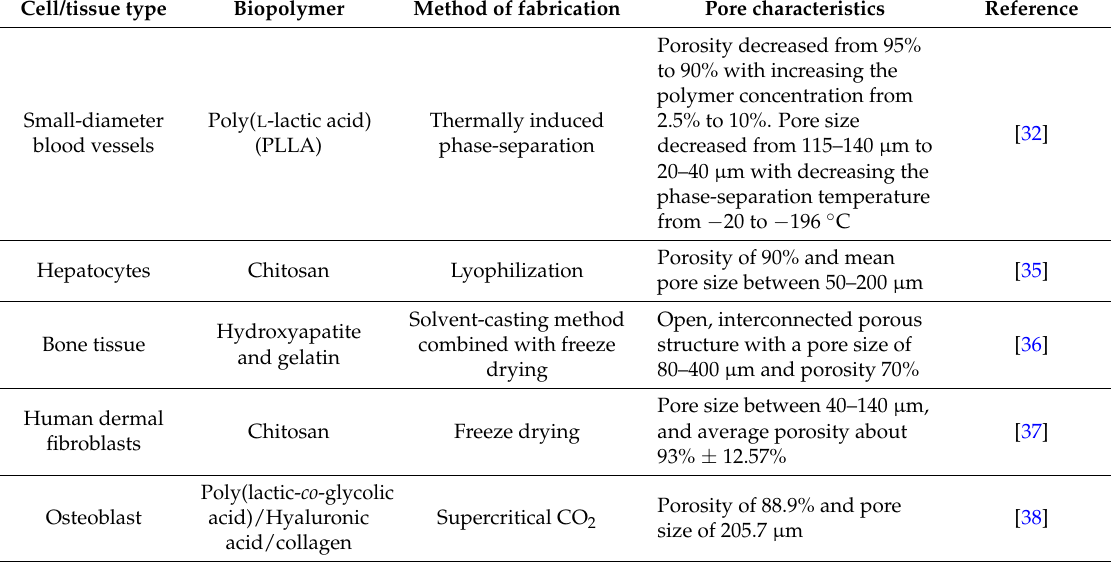
Table 2. Summary of pore characteristics of biopolymer scaffolds prepared from different fabrication methods for culturing different types of cells